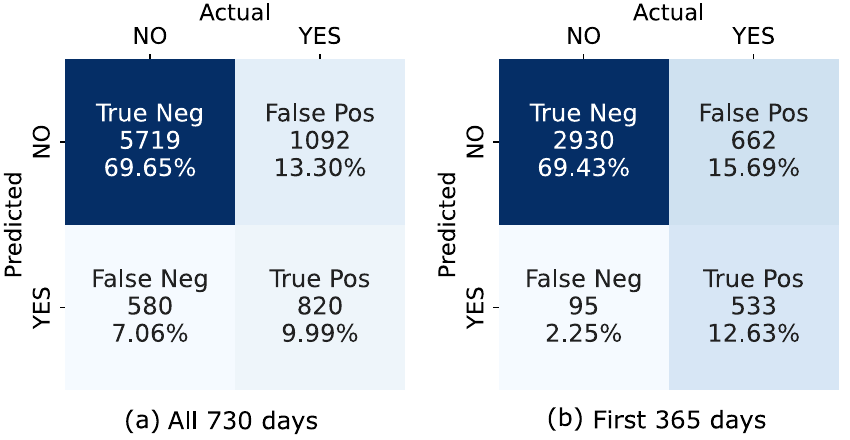
Figure 14. Confusion matrices for event detection, where the presented approach is applied to ( a ) all days of the dataset ([0, 730] days); ( b ) days of the warranty period of the sensors ([0, 365]